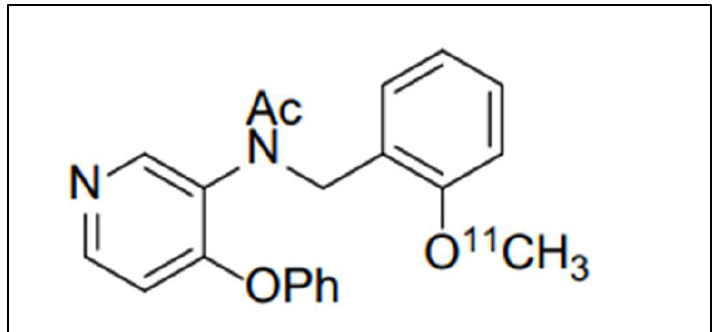
Figure 5. Chemical structure of the aryloxyanilide-based tracer N-(2-[ 11C]methoxybenzyl)-N-(4- phenoxypyridin-3-yl)acetamide, ([11C]PBR28) belonging to the phenoxypyridinylacetamides fam- ily.